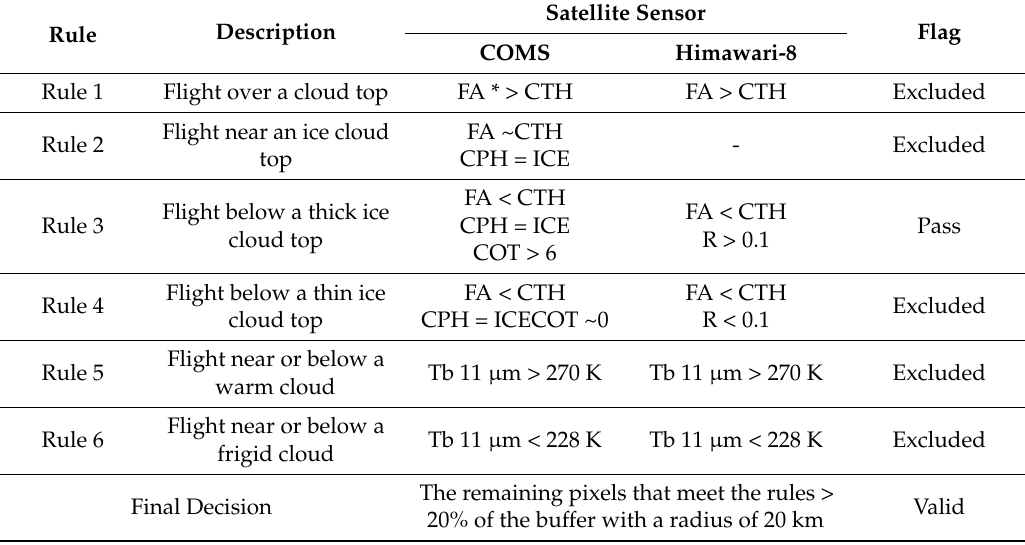
Table 2. Quality control rules for selecting pilot reports (PIREPs) to be used to develop icing detection models. Six rules were applied to each pixel in the buffer with a radius of 20 km at an icing PIREP location. Pixels that met the rules, except for rule 3, were excluded. A final decision as to whether an icing PIREP was valid or not was made using the remaining pixels within the buffer.